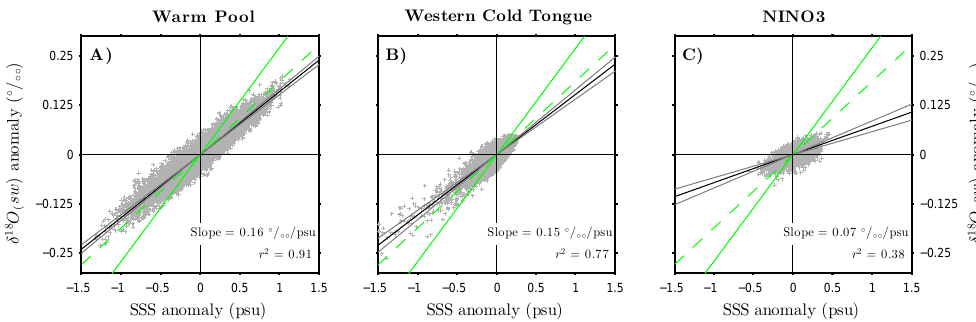
Fig. 7. Scatter plots of the relationships between the inter-annual monthly anomalies of δ 18 O sw and SSS as calculated for the spatial averaged indices over the Warm Pool, Western Cold Tongue and NINO3 boxes. The locations of these regional boxes are shown on Figs. 2, 4. The black regression lines show the best- fit linear regressions through the data, with the slope and r 2 values annotated on the plots. The grey lines show the two-tailed 95 % confidence bounds on the best-fit regression slopes, based on the assumption of an assumed decorrelation time of 4 yr. The solid green lines show the slope of 0.27 ‰ psu − 1 derived from a spatial regression of available instrumental data (LeGrande and Schmidt, 2006). The dashed green lines show the slope of 0.19 ‰ psu − 1 derived from a spatial regression (across all grid-squares in the tropical Pacific domain) of the temporal means of the model data.